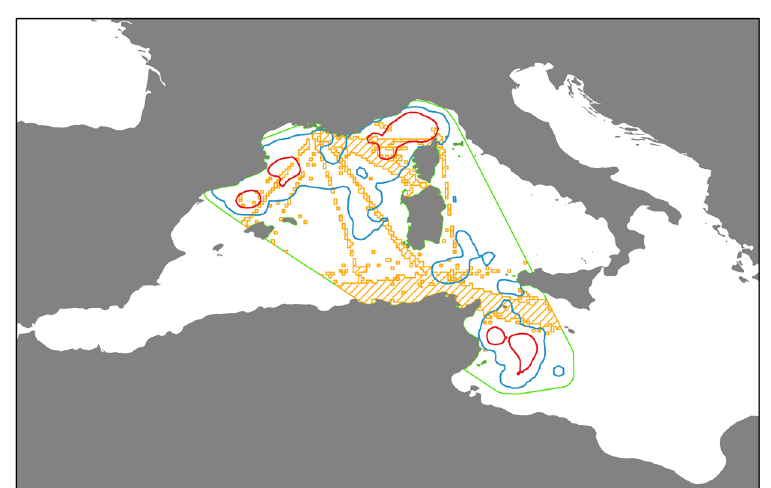
Figure 5. Overlapping of the 90% total home range areas and 50% core home range with regions of high traffic usage. Green dashed line represents the minimum bounding geometry enclosing all whale locations. Orange dashed area corresponds to areas of high traffic densities. Kernel derived total home ranges (90% isopleths) in blue and core home ranges (50% isopleths) in red. The map was produced with ArcGIS Desktop 9.3 (http://